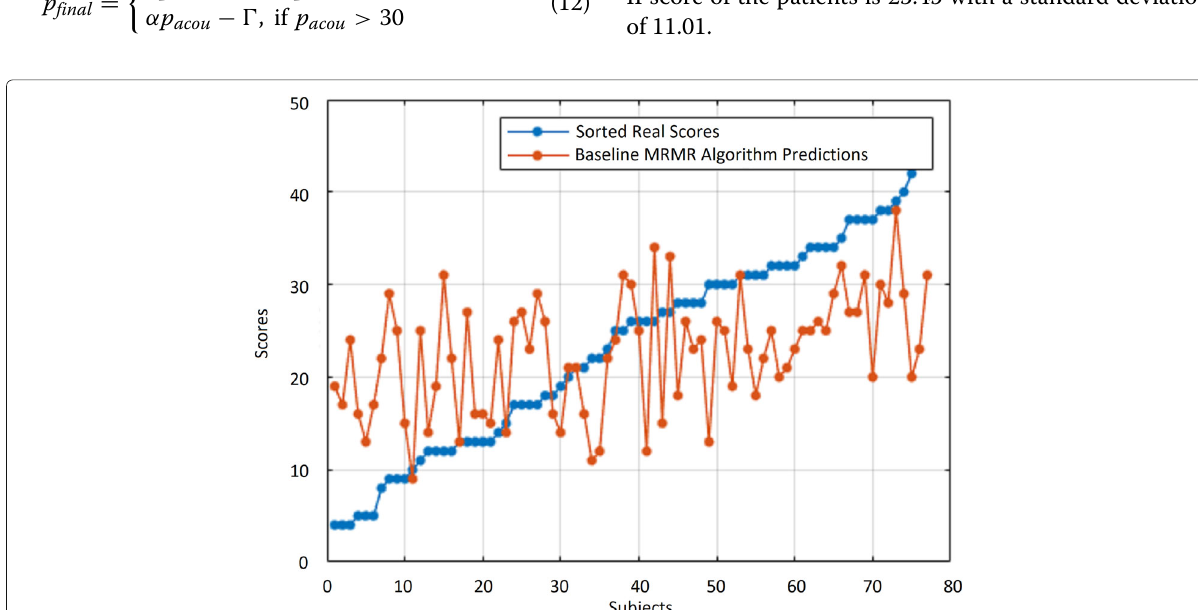
Fig. 5 Sorted real scores and the baseline MRMR predictions are compared using the Turkish and English databases for the regression task with the Turkish